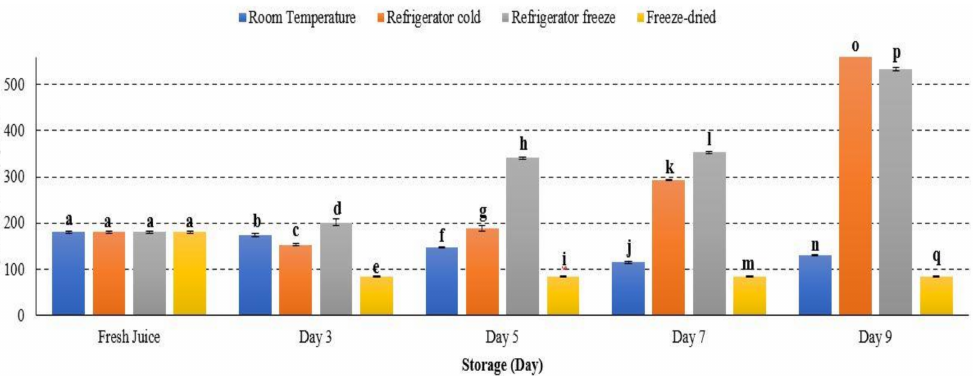
Figure 12. Lycopene quantification in watermelon juice. Different letters indicate significant differ- ences between samples p < 0.05.